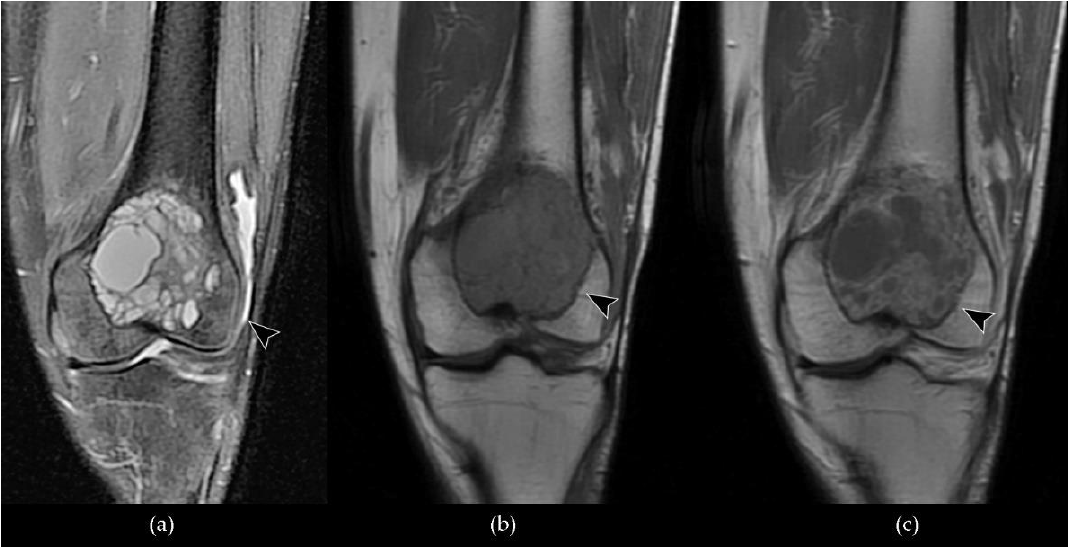
Figure 5. Coronal MRI of a GCTB of the distal metaepiphysis of the left femur (arrowhead) with associated joint effusion: ( a ) a fat-suppressed T2-W FSE scan shows a lesion with inhomogeneous signal hyperintensity in relation to the presence of multiple cystic components; ( b ) a T1-W FSE image shows non-uniform signal hypointensity; ( c ) a post-contrast T1-W FSE image demonstrates heterogeneous enhancement of the lesion, predominantly peripheral, and well discriminates the cystic and solid components.